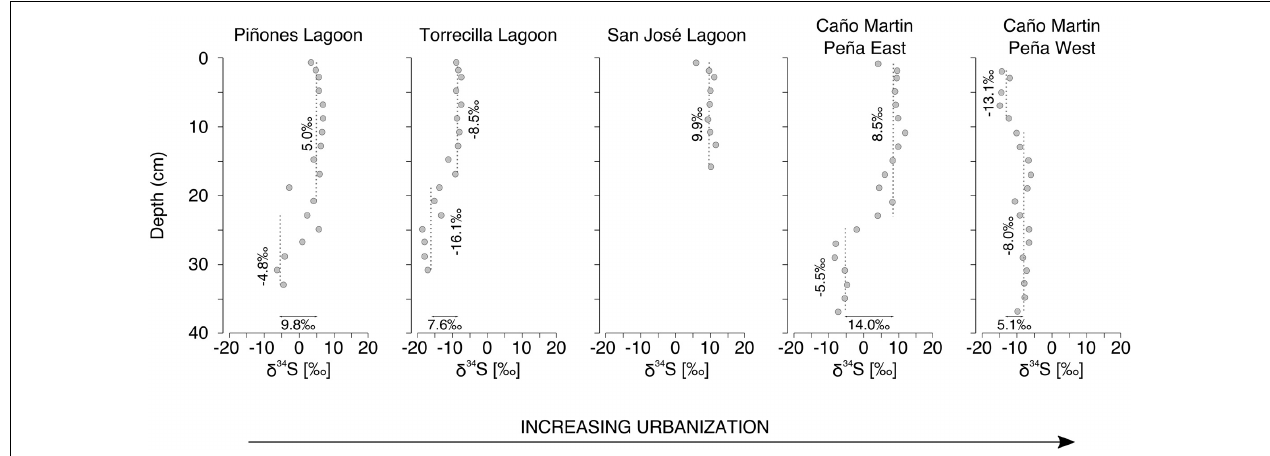
FIGURE 4 | Mangrove soil depth profiles of δ 34 S at sites along an urbanization gradient in the San Juan Bay Estuary.